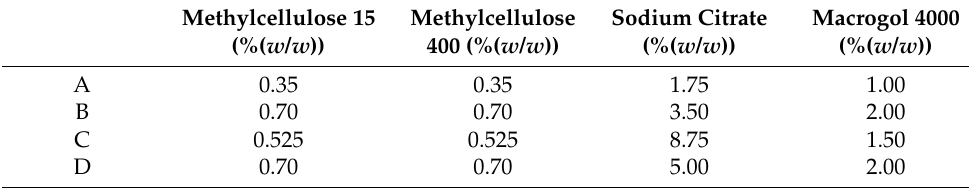
Table 1. Composition of temperature-sensitive